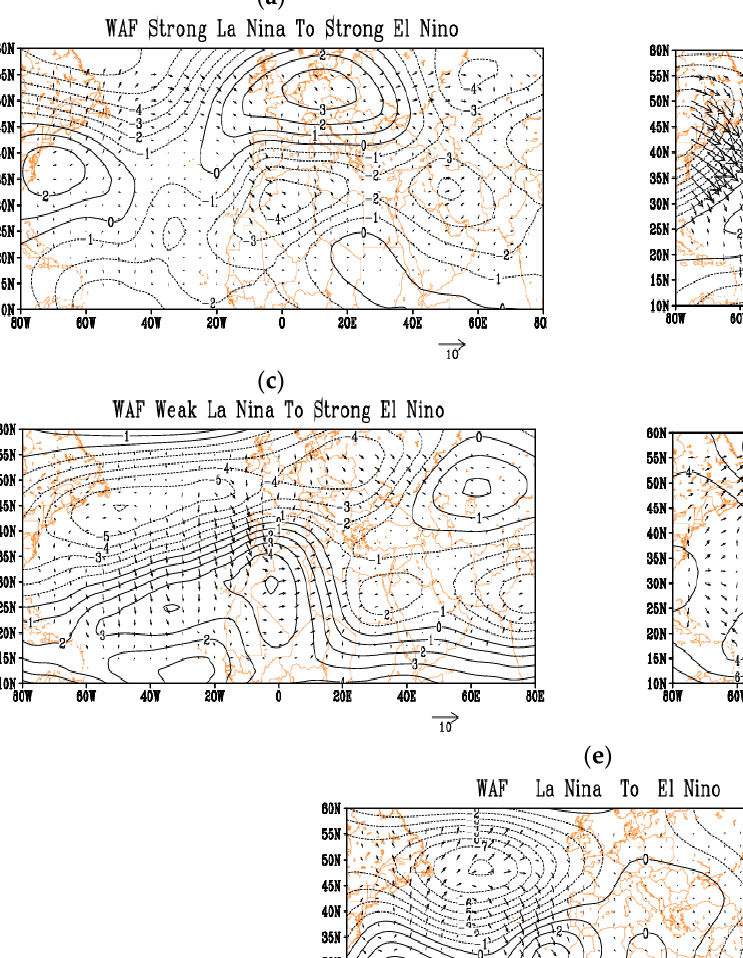
Figure 3. Anomalies in autumn (OND) horizontal flux of wave activity (arrows) and its divergence (contours) for ENSO phase transition type 1 years. The first four panels ( a – d ) show patterns for different cases, while the final panel ( e ) shows the average over all the type 1 year. Units for the arrows are m 2 /s 2 and for contours 10 6 m 2 /s.